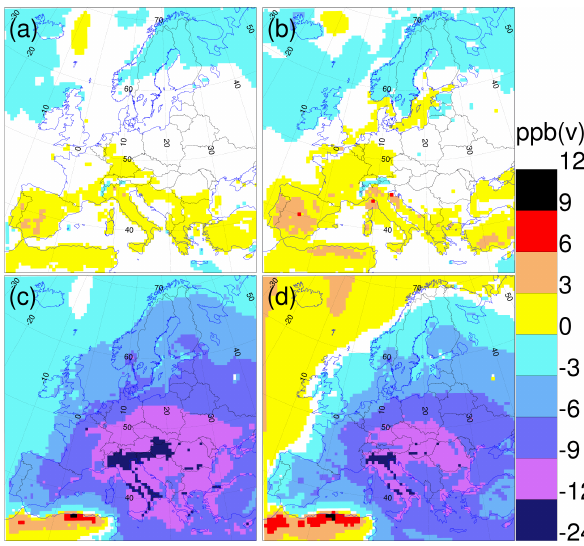
Fig. 4. Change in summer (April–September), daily maximum, surface O 3 concentration from 1990–2009 to 2040–2059. (a) and (b) changes due to change in climate only; RCA3 downscaling of ECHAM5 and HadCM3, respectively. (c) ECHAM5 downscal- ing and change in European O 3 precursor emissions. (d) Increas- ing boundary case; the change due to combined change in climate, change in O 3 precursor emissions and an increasing hemispheric background of O 3 of 0.1ppb(v)yr − 1 . Non-significant changes at 95% confidence level are masked